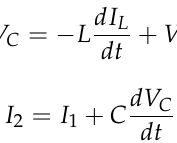
Figure 6. Basic operational waveforms during mismatch: ( a ) Current flowing through the inductor L , ( b ) Current flowing through the capacitor C , where T is the switching period.